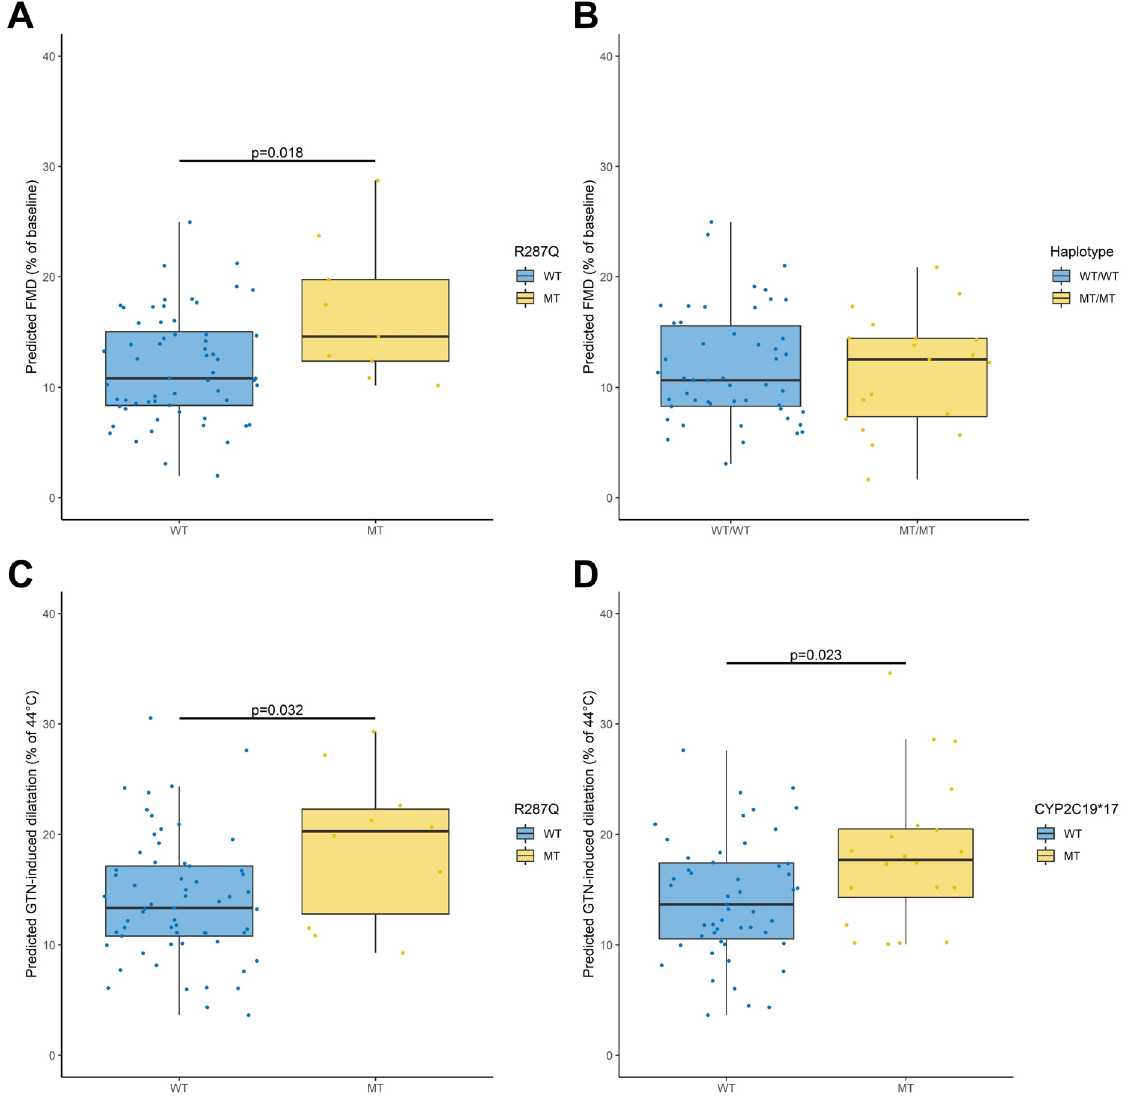
Figure 3. Impact of R287Q ( A ) and CYP2C8*3/2C9*2 ( B ) polymorphisms on radial artery endothelium- dependent flow-mediated dilatation in response to hand skin heating and of R287Q ( C ) and CYP2C9*17 ( D ) on